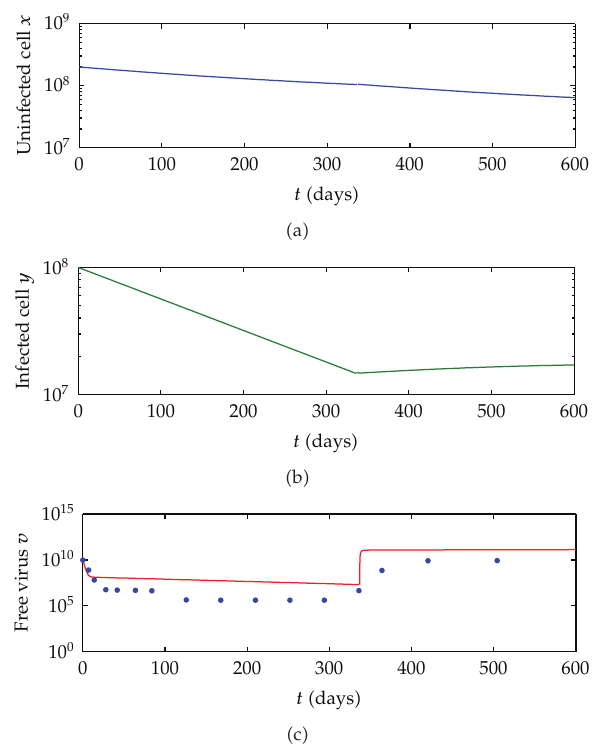
Figure 1: The numerical solution of system (cid:3) 5.1 (cid:4) . (cid:3) a (cid:4) Uninfected cells x ; (cid:3) b (cid:4) infected cells y ; (cid:3) c (cid:4) virus declines in response to drug treatment and virus resurges as soon as the drug is withdrawn in which the clinical data are marked by